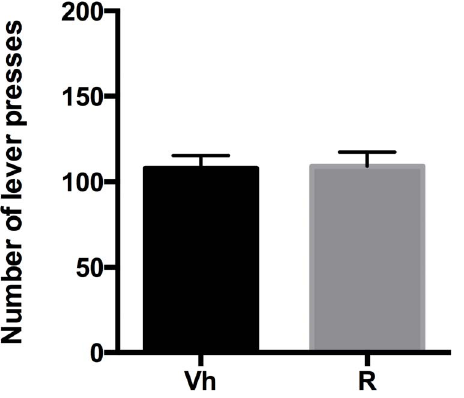
Figure 4. Ropinirole and Extinction. Number of lever presses during the 20-min Extinction session, in vehicle (Vh) - and ropinirole (R) treated rats.